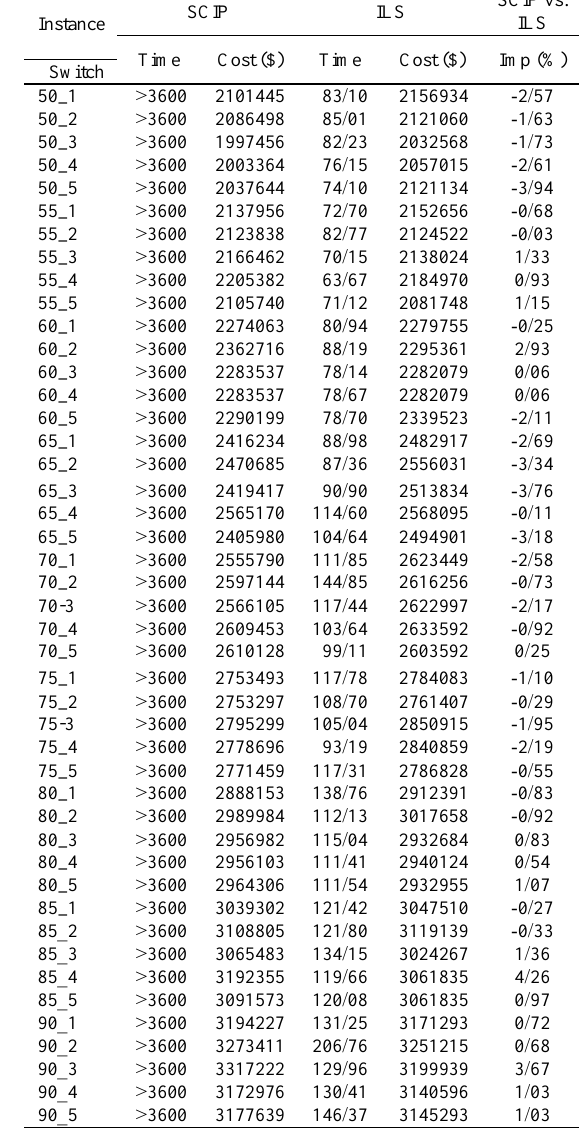
Table 4. Results obtained from ILS algorithm and SCIP on instances of medium size.